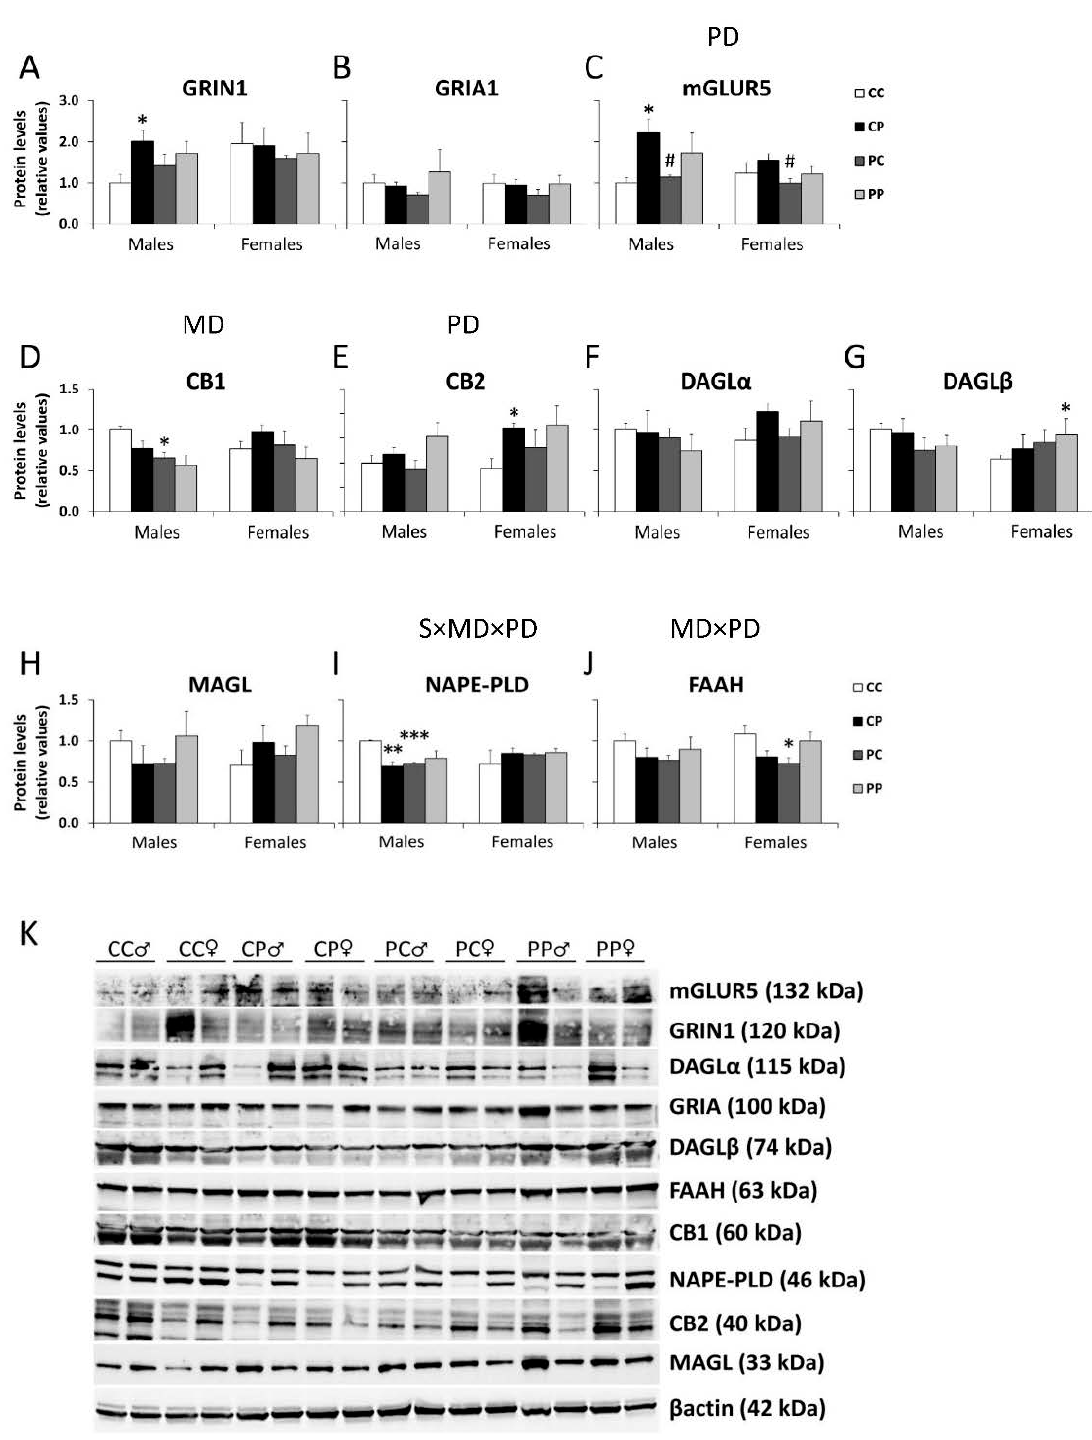
Figure 4. Effect of maternal and/or offspring exposure to a free-choice palatable (P) diet on the relative protein levels of: ( A ), GRIA1 ( B ), mGLUR5 ( C ), CB1 ( D ), CB2 ( E ), DAGL α ( F ), DAGL β ( G ), MAGL ( H ), NAPE-PLD ( I ) and FAAH ( J ) in the prefrontal cortex of male and female offspring in adulthood. Representative immunoblots ( K ). Data are expressed as the mean ± S.E.M. ( n = 4). Student’s t test: * / ** / *** p < 0.05/0.01/0.001 vs. CC males or CC females; # p < 0.05 vs. CP males or CP females. MD: maternal diet effect; PD: postnatal diet effect; MDxPD: maternal and postnatal diets interaction; SxMDxPD: sex, maternal diet and postnatal diet interaction.